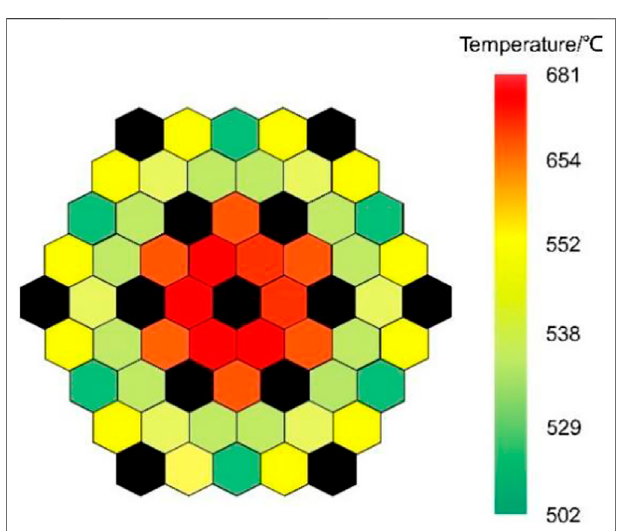
Frontiers in Energy Research |